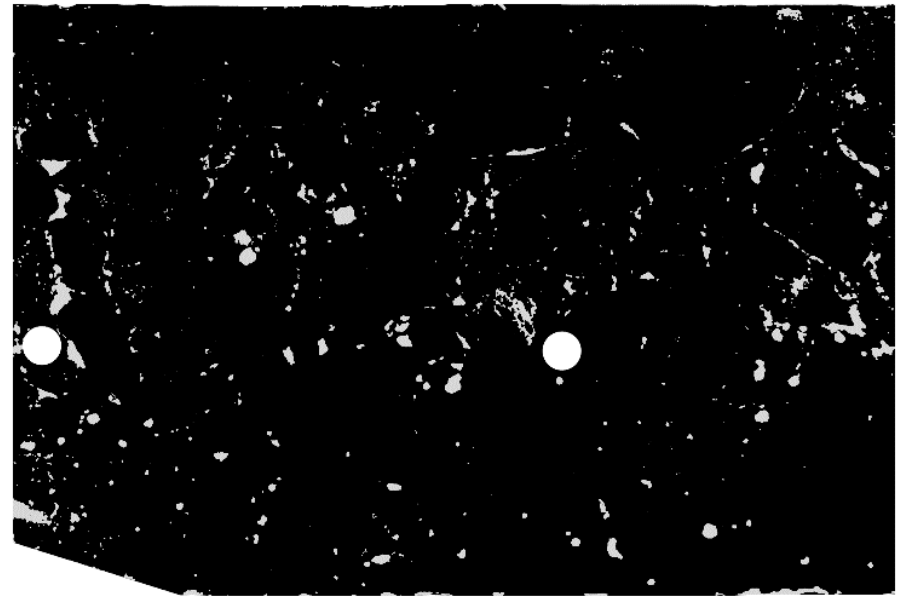
Figure 10. Binary image of pores (limited to ROI).